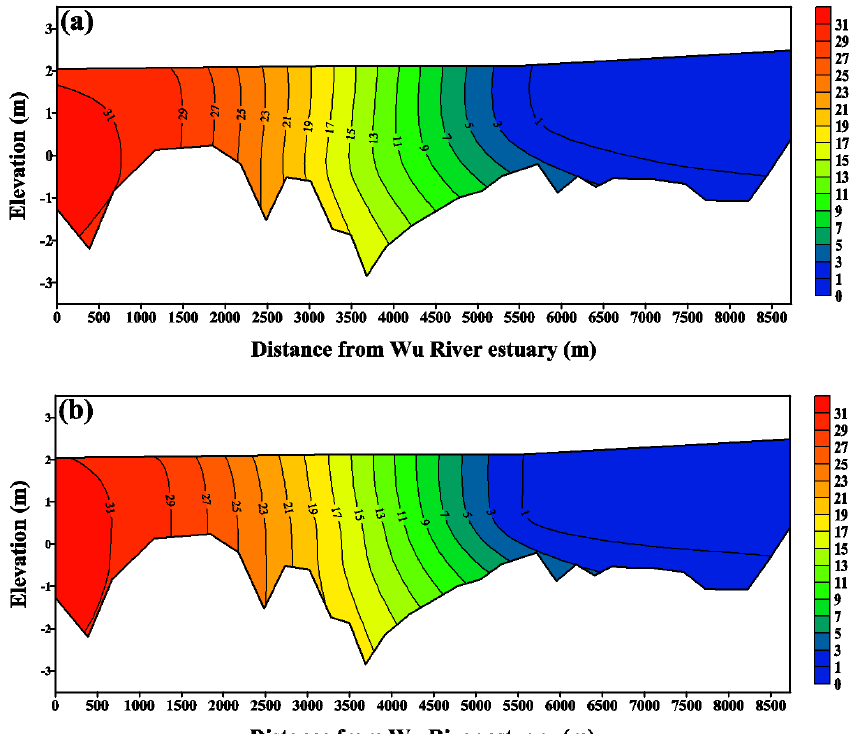
Figure 8. Comparison of salinity distribution along the Wu River estuary. ( a ) measurements and ( b ) model simulation on 29 July 2011 for model